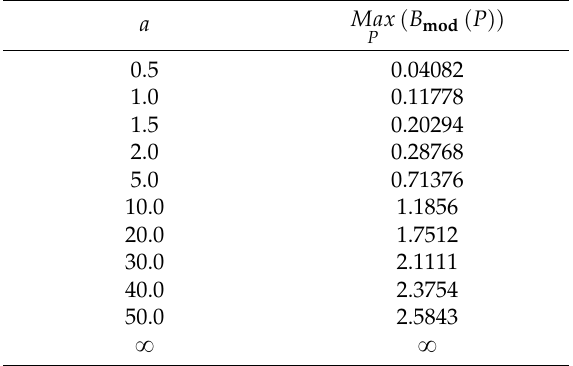
Table 1. The a values & maximum values of Burg’s Modified